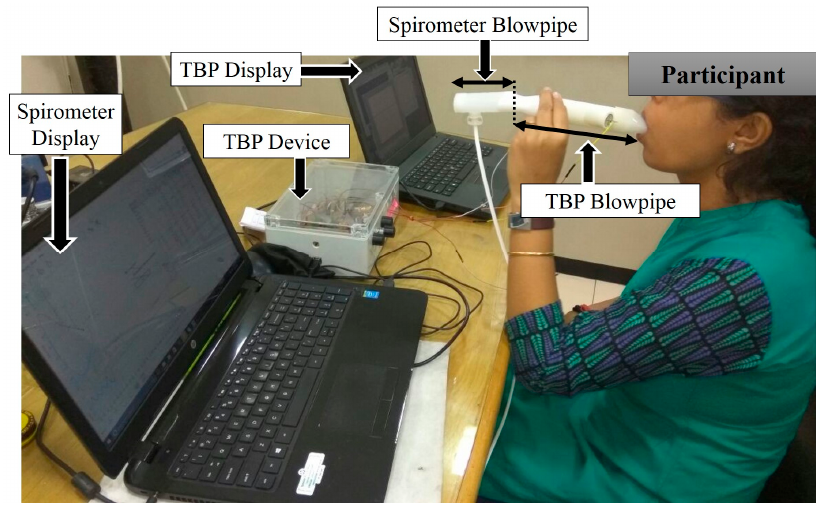
Figure 10. Subject breathes through the blowpipes of TBP and spirometer (connected in series) during the system validation phase. Table 3. Comparison of PIF and PEF computation with a spirometer and our TBP system.